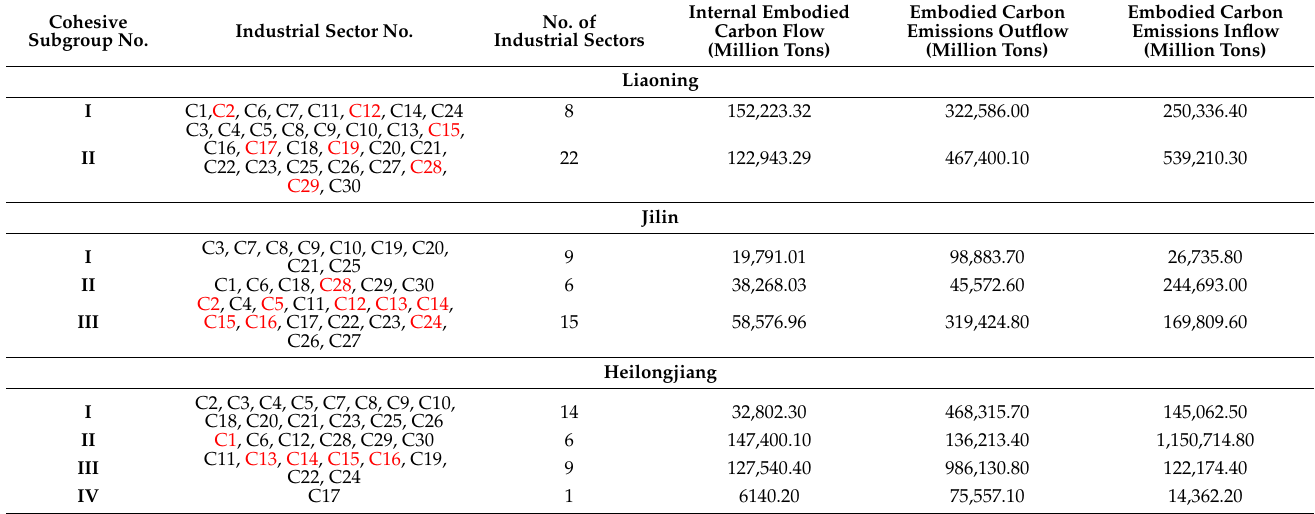
Table 9. Description of the structure of the cohesive subgroup in Hei-Ji-Liao